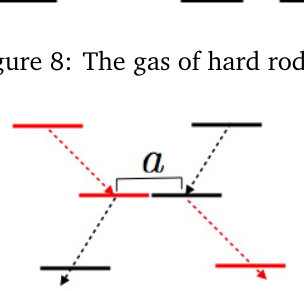
Figure 8: The gas of hard rods.